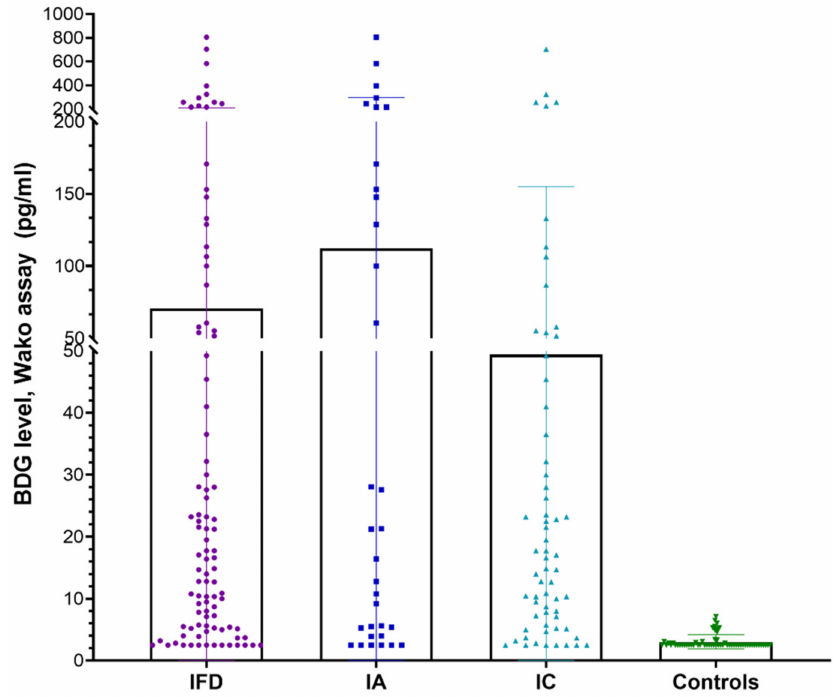
Figure 1. Comparative BDG levels were observed in various patient groups using the Fujifilm Wako BDG estimation